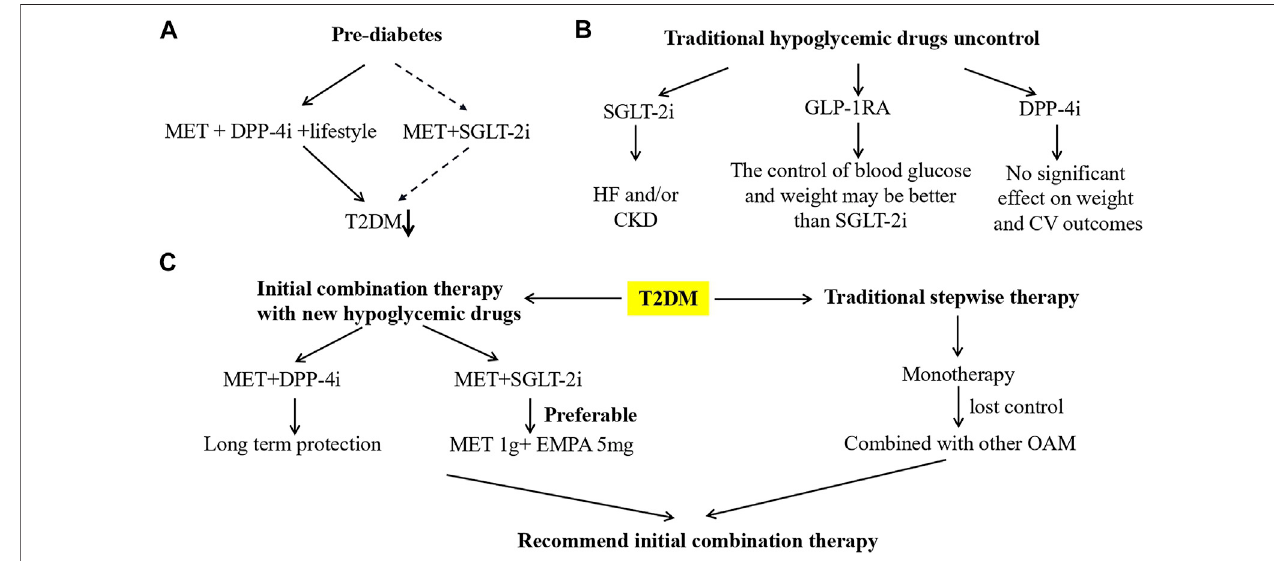
FIGURE 1 | Combined use of hypoglycemic drugs in different situations. (A) Pre-diabetes is a very common health problem, and the risk of progression to T2DM and/or diabetes complications is high. But given the reduced morbidity in the short term, and the modest bene fi t in terms of side effects and/or lack of proven cardiovascular bene fi t. On this basis, the FDA and EMA in the United States and Europe announced that there are no drugs recommended for T2DM prevention. Nevertheless, DPP-4i (linagliptin) + MET + lifestyle may be a valuable option for reducing the risk of patients with prediabetes. In addition, for SGLT-2i (such as dapagli fl ozin) combined with MET may have similar or better effects (because metformin and dapagli fl ozin can decrease the risk of new-onset diabetes by 31 and 32%, respectively). (B) For T2DM patients who have been using hypoglycemic drugs, when the traditional treatment drugs are not effective, SGLT-2iand/or GLP-1RA and/or DPP-4i can be further added for treatment. For T2DM patients with HF and/or CKD, SGLT2i is preferred. GLP-1RA may be better than SGLT2i in controlling blood glucose and body weight, (for differences between different GLP-1RAs, please see the second paragraph of 2.1), while DPP-4i has no signi fi cant effect on body weight andCVoutcome. (C) ForT2DMpatientswhohavenotpreviouslyusedhypoglycemicdrugs,comparedwithtraditionalstepwisetherapy,theinitialcombinationofMET+ DPP-4iprovideslong-termbene fi ts.Inaddition,comparedwithMETorSGLT-2imonotherapy,theinitialMET+SGLT-2icombinationtherapyhassigni fi cantadvantages in controlling blood glucose and body weight. Moreover, MET 1 g + EMPA 5 mg (both twice daily) combined therapy is superior to empagli fl ozin 25 mg/d or metformin 1 g twice daily in controlling blood glucose and weight. Abbreviations: CKD, chronic kidney disease; CV, cardiovascular; DPP-4i, dipeptidyl peptidase-4 inhibitors; EMPA, empagli fl ozin; GLP-1RA, glucagon-like peptide 1 receptor agonists; HF, heart failure; Met, metformin; OAM, oral antihyperglycemic medication; SGLT-2i, sodium-glucose cotransporter 2 inhibitors; T2DM, type 2